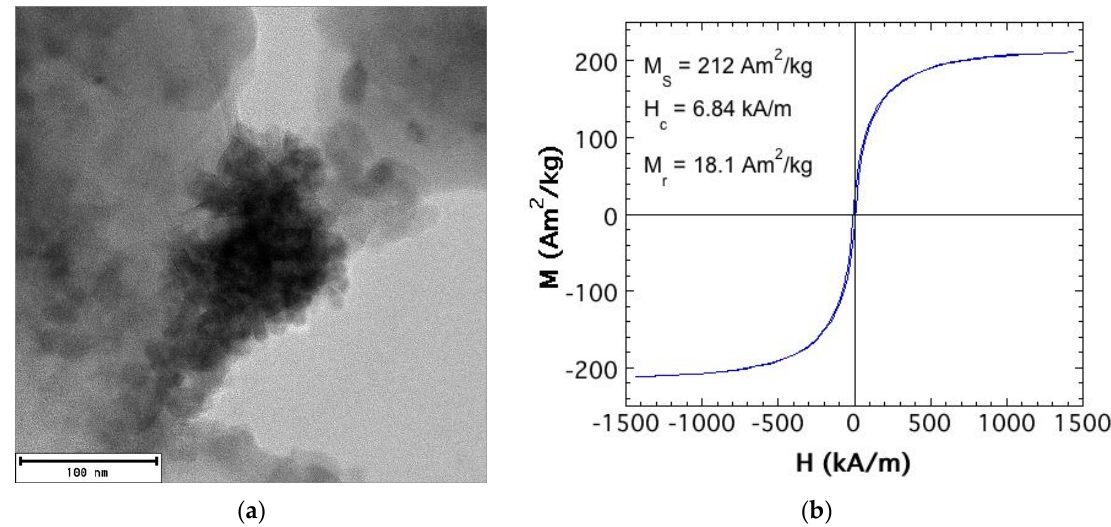
Figure 1. ( a ) TEM microphotograph of an agglomerate (about 200 nm in size) of the synthesized FeCo single nanoparticles (about 30–50 nm in size); ( b ) Room temperature hysteresis loop of the FeCo nanoparticle powder obtained after fabrication by the chemical reduction technique.